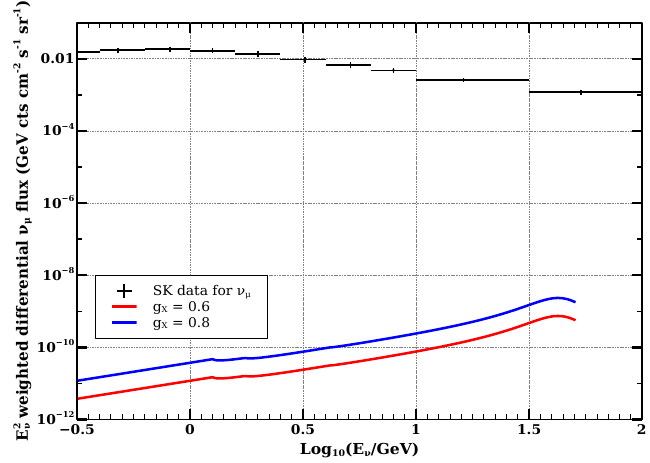
d Φ νµ for g = 0 . 6 (red line), g X ν dE ν flux measured by the SK detector µ